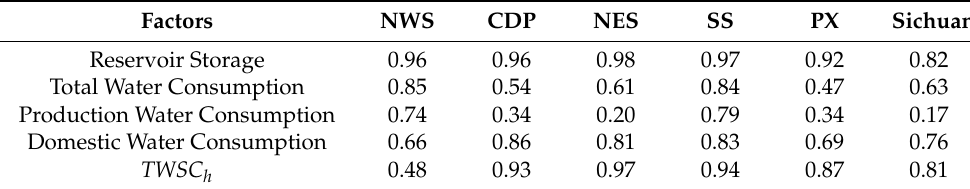
Table 8. The correlation coefficients between different factors from human activities and TWSC in Sichuan and its five